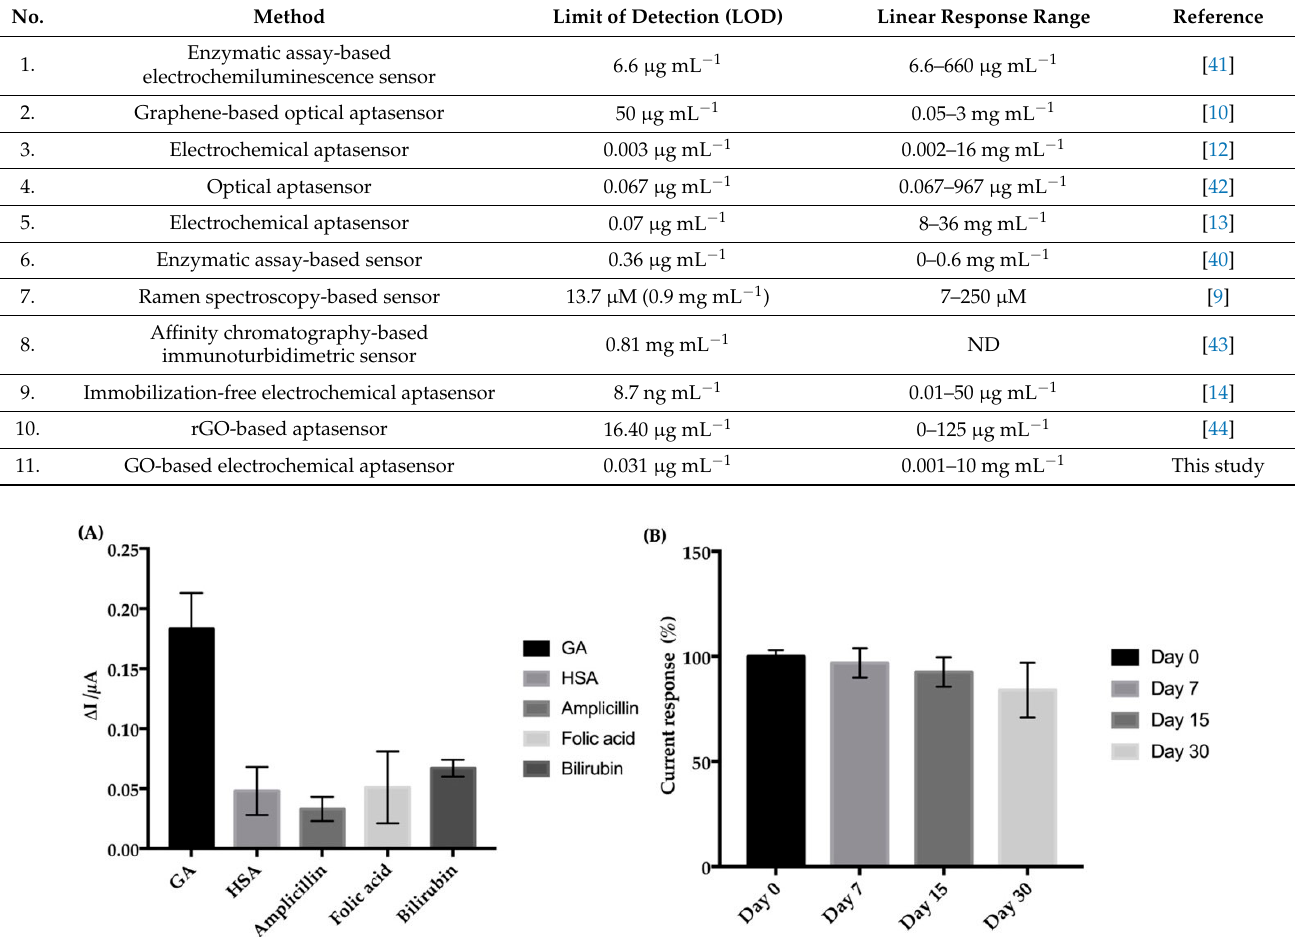
Figure 6. ( A ) Specificity of electrochemical aptasensor to GA compared with other biomaterials HSA (50 µg mL − 1 ), folic acid (160 µg mL − 1 ), ampicillin (5mg mL − 1 ) and bilirubin (5 mg dL − 1 ). ( B ) Stability of the aptasensor after a storage at 4 °C for 0, 7, 15 and 30 days for detection of 1 mg mL − 1 of GA.